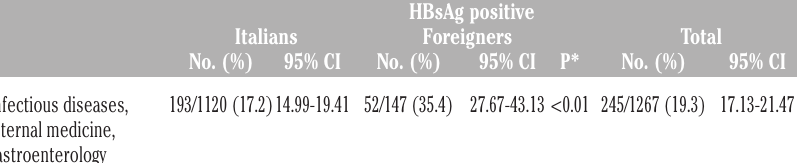
Table 4. Hepatitis B surface antigen (HBsAg) seropositivity in Italian and non-Italian patients by hospital department (2007-2008).